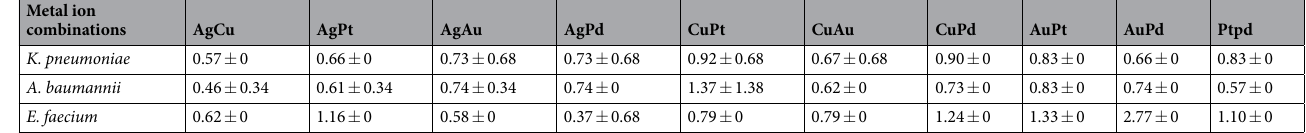
Table 3. Fractional inhibitory concentration index for metal ion combinations demonstrating a synergistic antimicrobial efficacy for silver/copper against K. pneumoniae and silver/palladium against E. faecium .